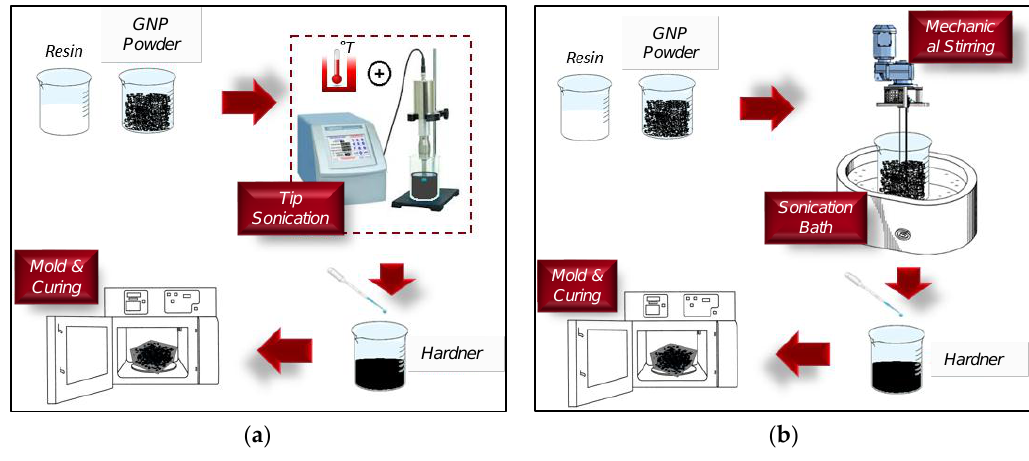
Figure 3. Sketch of GNP-composite production processes: ( a ) epoxy-based system; and ( b ) vinyl ester-based system.